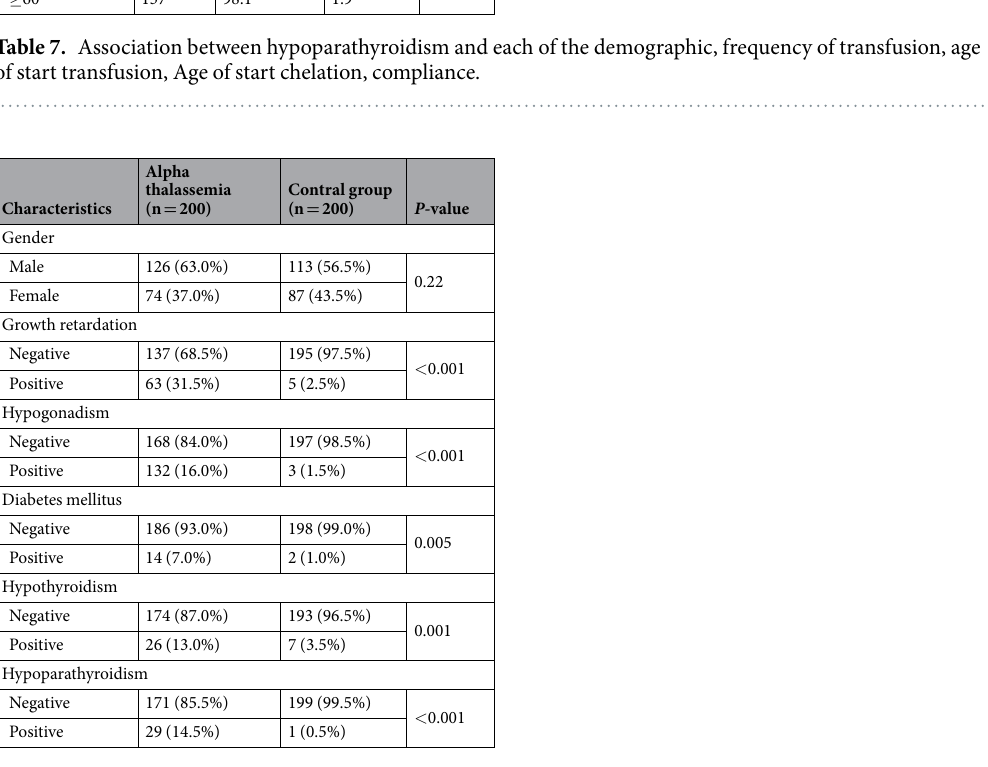
Table 8. Comparison of endocrine complications in patients with alpha thalassemia and control